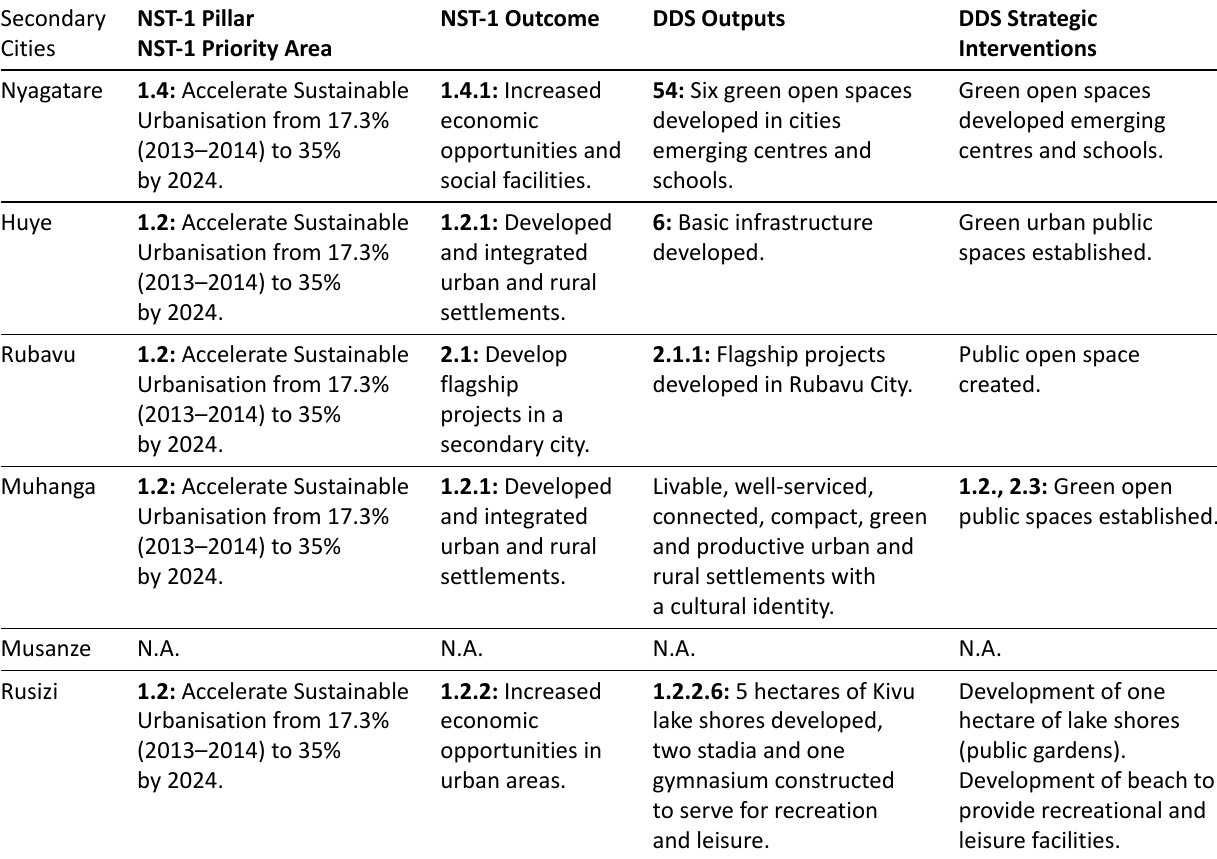
Table 1. Provision of public space in DDSs 2018–2024 for six secondary